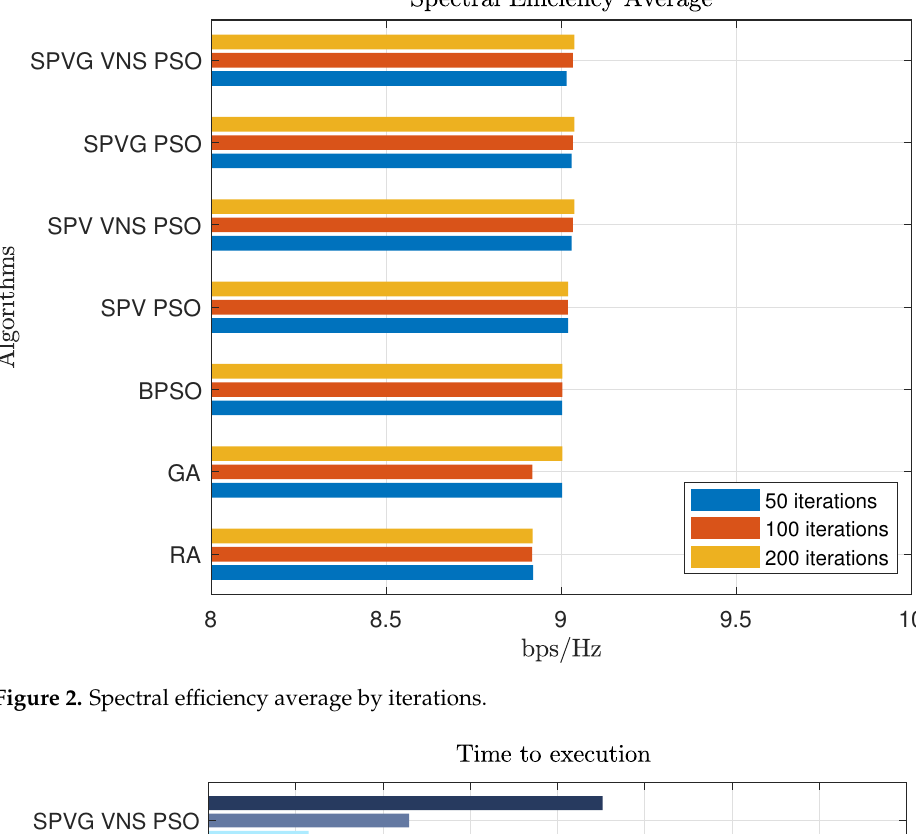
Figure 2. Spectral efficiency average by iterations.